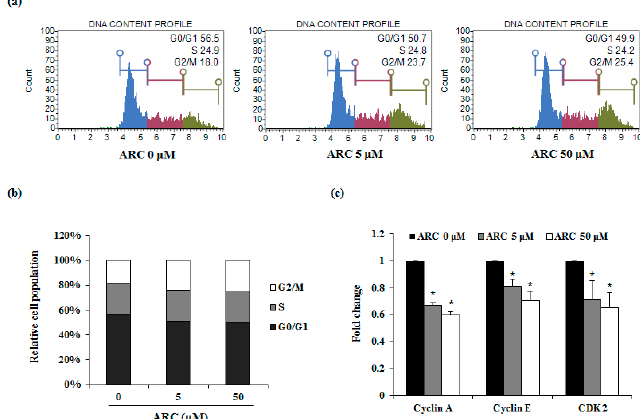
Figure 2. ARC induces cell death via cell cycle arrest. ( a ) Cell cycle analysis of CT26 cells after ARC treatment for 24 h; ( b ) the percentage of cell cycle phases; and ( c ) mRNA expression levels of cyclin A, cyclin E and CDK2. CT26 cells were treated with ARC for 24 h. Results are expressed as the mean ± SD. * p <